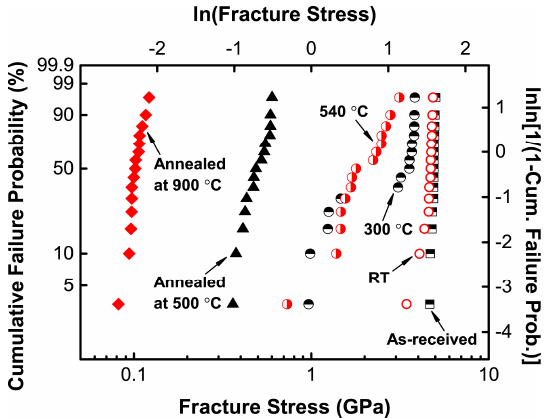
Figure 4. Weibull plot of the tensile strengths of the bare silica optical fibers annealed at 500 °C and 900 °C respectively and tested at room temperature (26 °C), compared with those of the bare fibers without annealing tested at room temperature (26 °C), 300 °C and 540 °C, as well as the as-received fibers tested at room temperature (26 °C) [26]. RT: room temperature